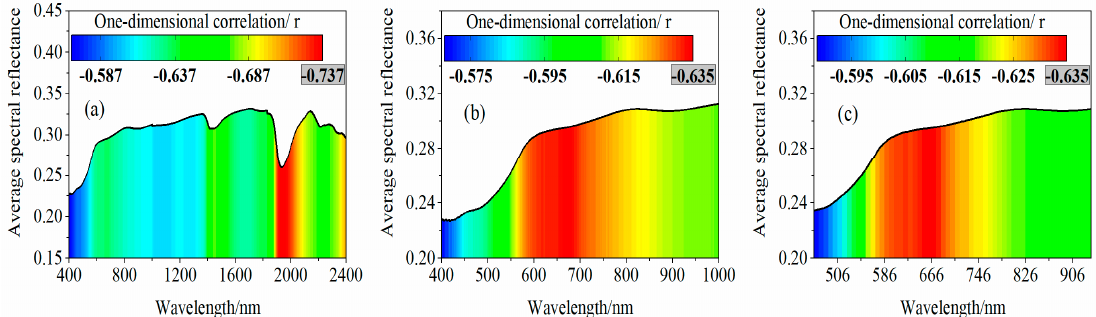
Figure 8. One-dimensional r diagram between SMC and original spectrum. ( a ) r diagram between SMC and 400–2400 nm spectra; ( b ) r diagram between SMC and 400–1000 nm spectra; ( c ) r diagram between SMC and 466–938 nm spectra.